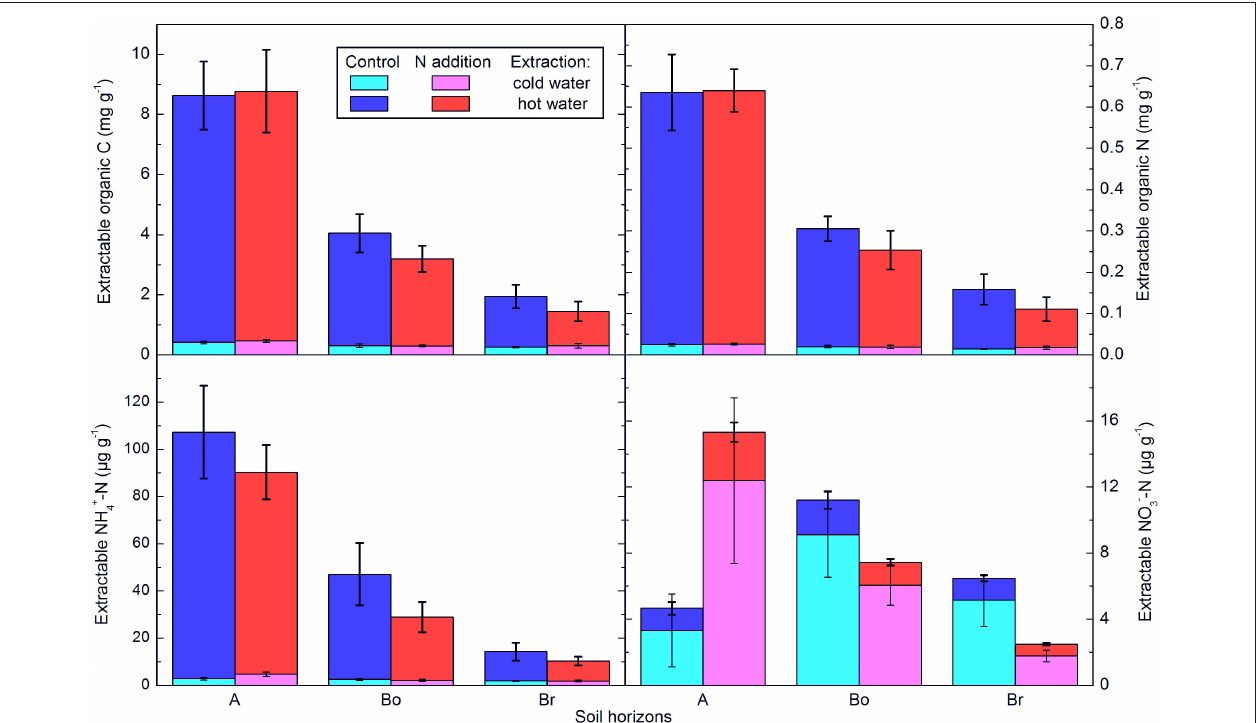
FIGURE 1 | Extractable C and N concentrations in the horizons of the mineral soil in the control and N-addition plots. A first extraction was done with cold water and a subsequent one with hot water. All results are from three cores per plot and given per dry soil mass as averages ± standard error ( n = 5; A, A horizon; Bo, oxic B horizon; Br, reduced B